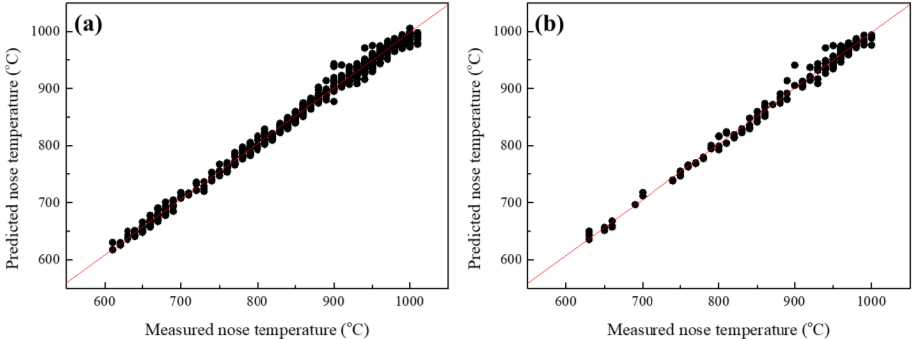
Figure 9. A prediction result of nose temperature with two datasets. ( a ) training, ( b )